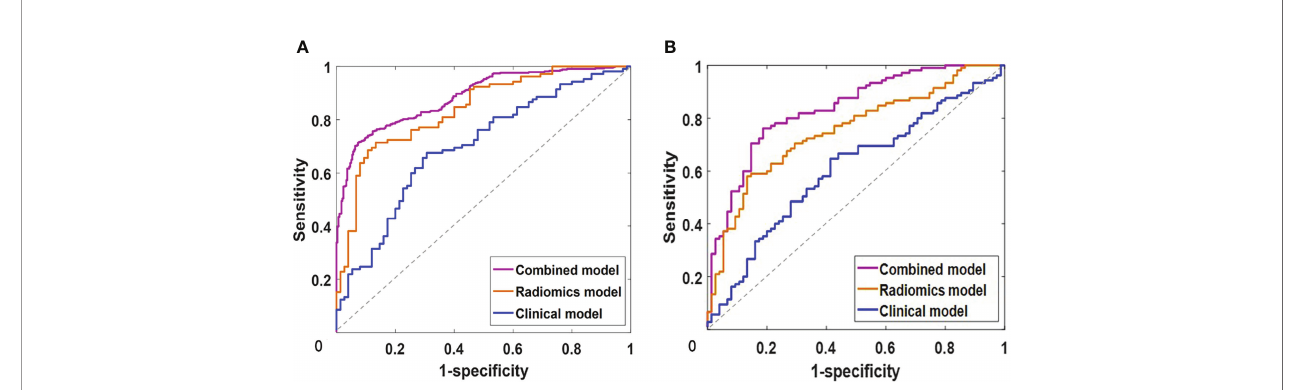
FIGURE 6 | The receiver operating characteristics (ROC) curve analysis of clinical, radiomics and combined models with support vector machine in training (A) and testing (B)